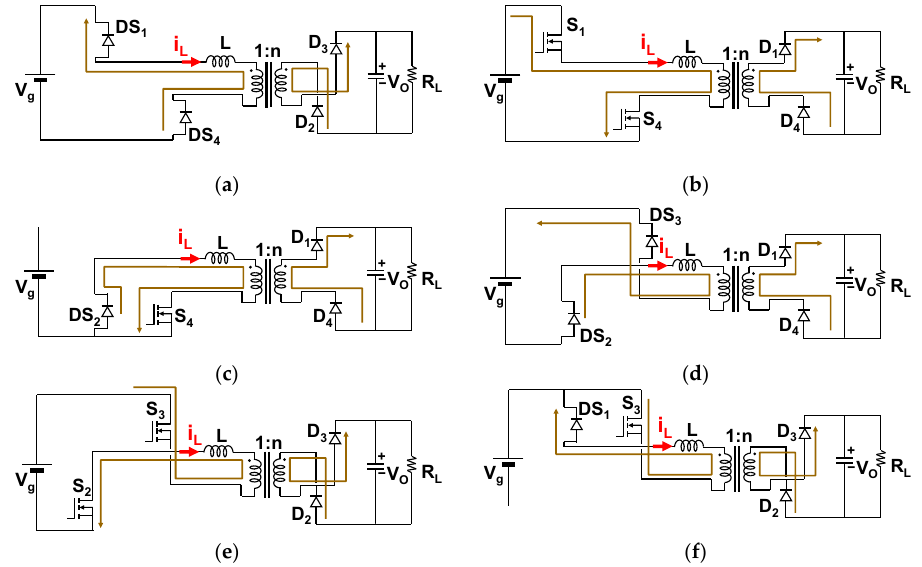
Figure 2. Lineal subcircuits of operation of SAB converter in CCM. ( a ) Interval ( t 0 , t 1 ), ( b ) interval ( t 1 , t 2 ), ( c ) interval ( t 2 , t 3 ), ( d ) interval ( t 3 , t 4 ), ( e ) interval ( t 4 , t 5 ) and ( f ) interval ( t 5 , t 6 ).